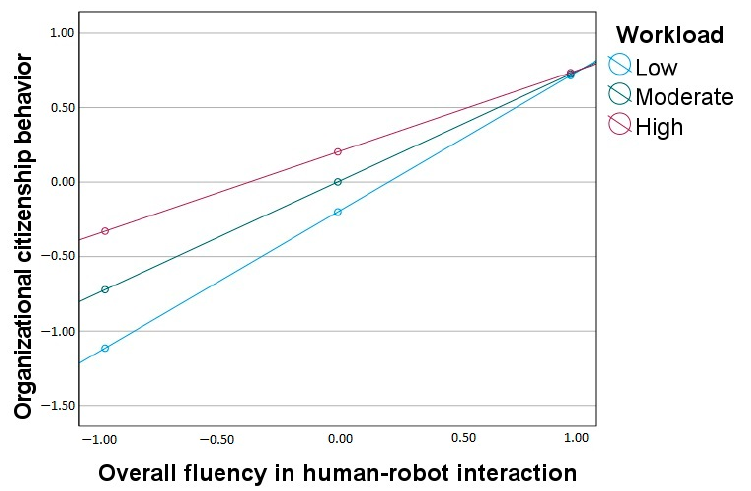
Figure 2. Workload as a moderator between overall fluency in human-robot interaction and organi- zational citizenship behavior.